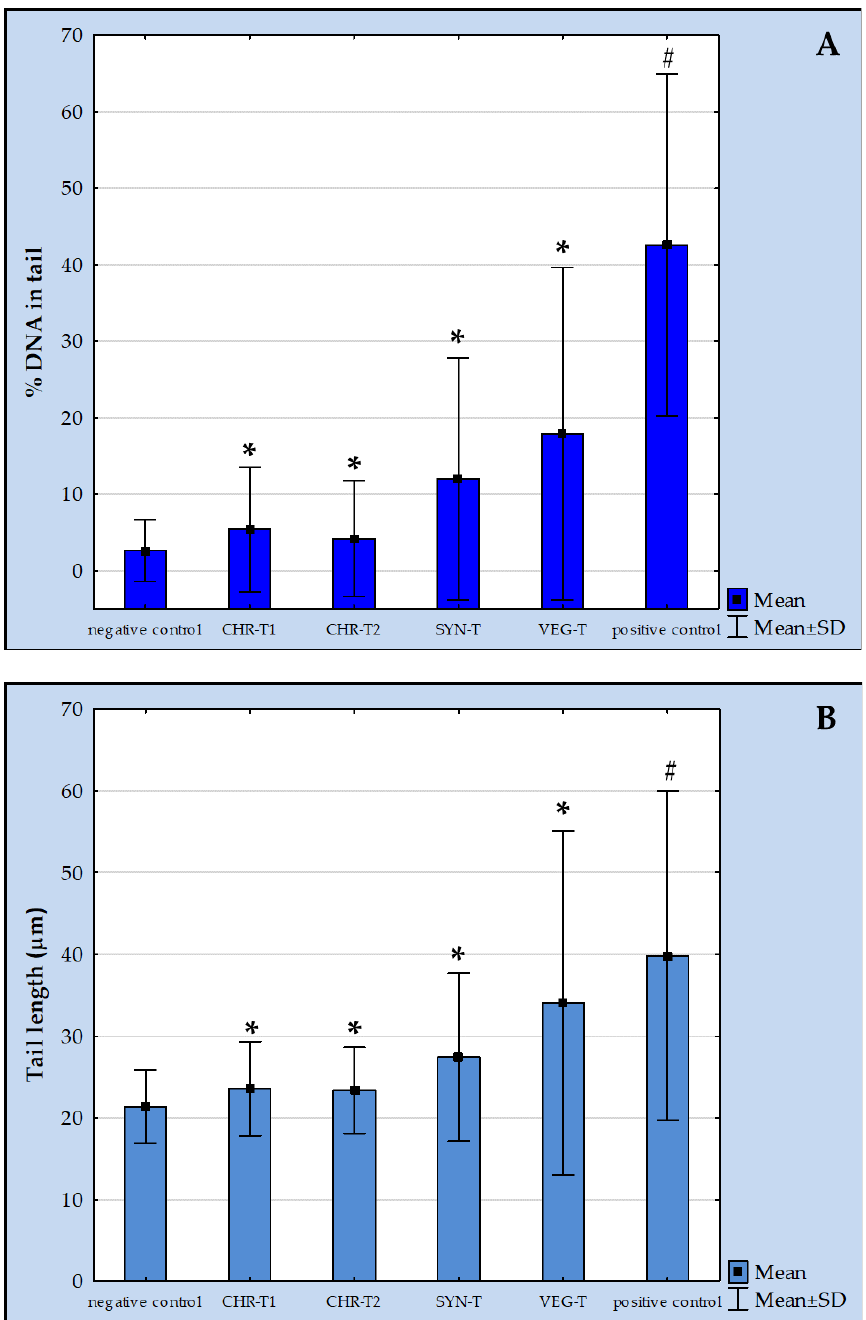
Figure 1. The extent of primary DNA damage in HepG2 cells measured by the alkaline comet assay after 24 h exposure to the leather samples tested and the corresponding negative and positive controls. The main comet descriptors were %DNA in tail ( A ) and tail length ( B ). CHR-T1 and CHR-T2 correspond to the leather sample processed with two chrome tanning procedures; SYN-T corresponds to the leather sample processed with synthetic tanning; VEG-T corresponds to the leather sample processed with vegetable tanning. Results are reported as mean ± standard deviations obtained by the measurements of 300 comets per experimental group. *—significantly increased compared to negative control; #—significantly increased compared to all other experimental groups ( p < 0.05; Mann – Whitney U test).